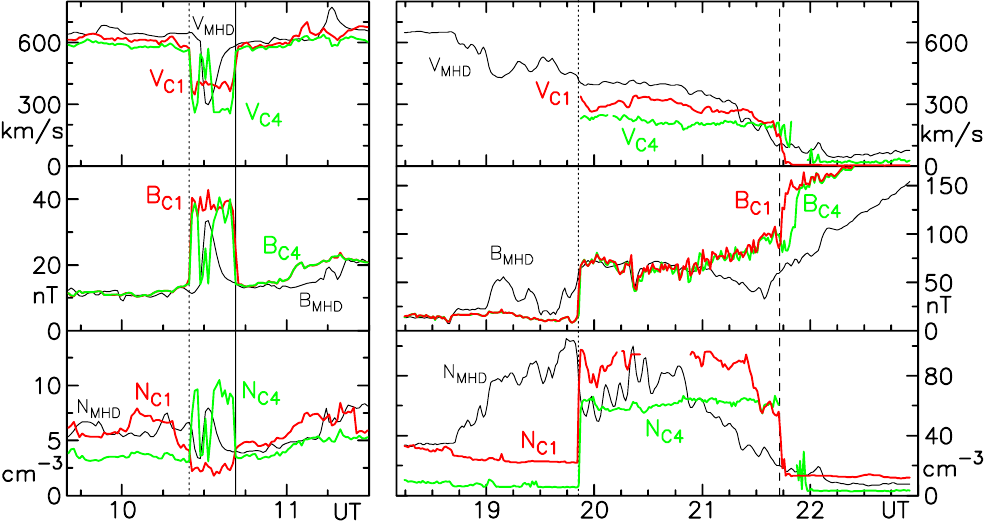
Fig. 3. 17 January 2005. Solar wind velocity V , magnetic field B , and proton number density N measured by Cluster 1 in red and by Cluster 4 in green. The same parameters for the trajectory of Cluster 1 provided by a global 3-D MHD model run in CCMC (black curves). Observed inbound bow shock crossings at 10:25 and 19:51UT marked by dotted lines; outbound crossing at 10:42UT shown by solid line; inbound magnetopause crossing at 21:43UT marked by dashed